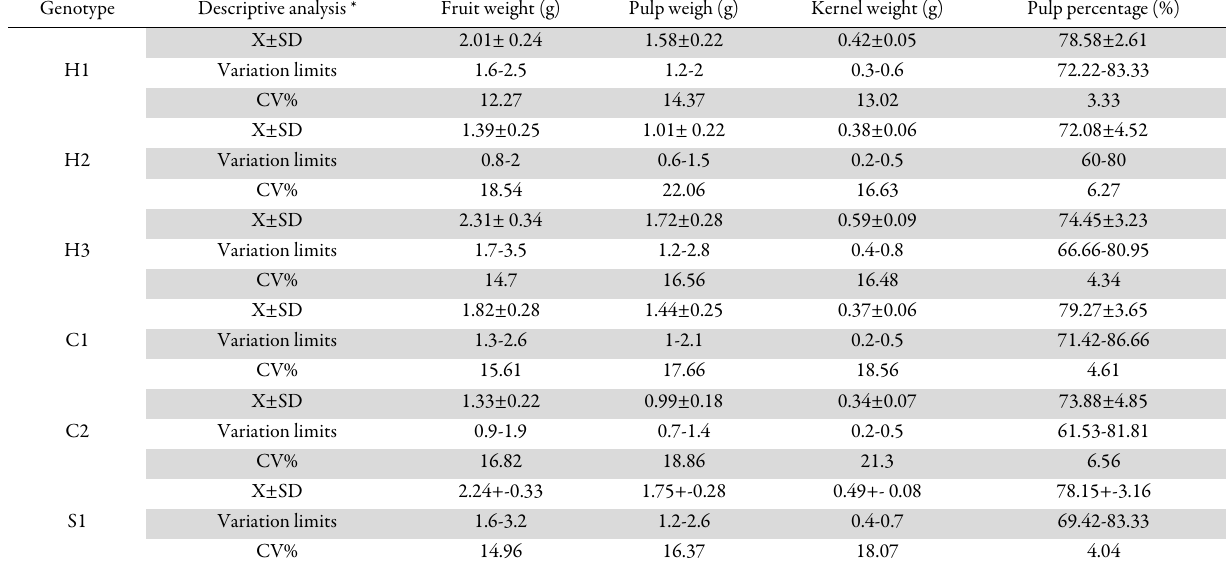
Table 2. Quantitative values of fruits in the six genotypes under study